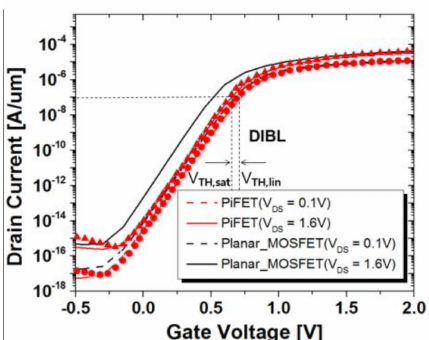
Figure 1. I DS -V GS characteristics for a V DS of 0.1 [V] and 1.6 [V], and the definition of DIBL. The red symbol shows the measured drain current of the fabricated PiFET structure with 0.1 µ m DRAM